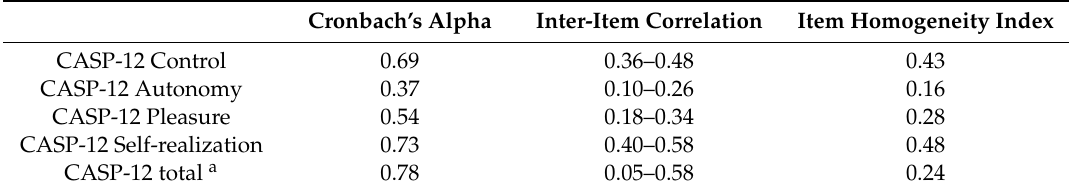
Table 5. Internal consistency of